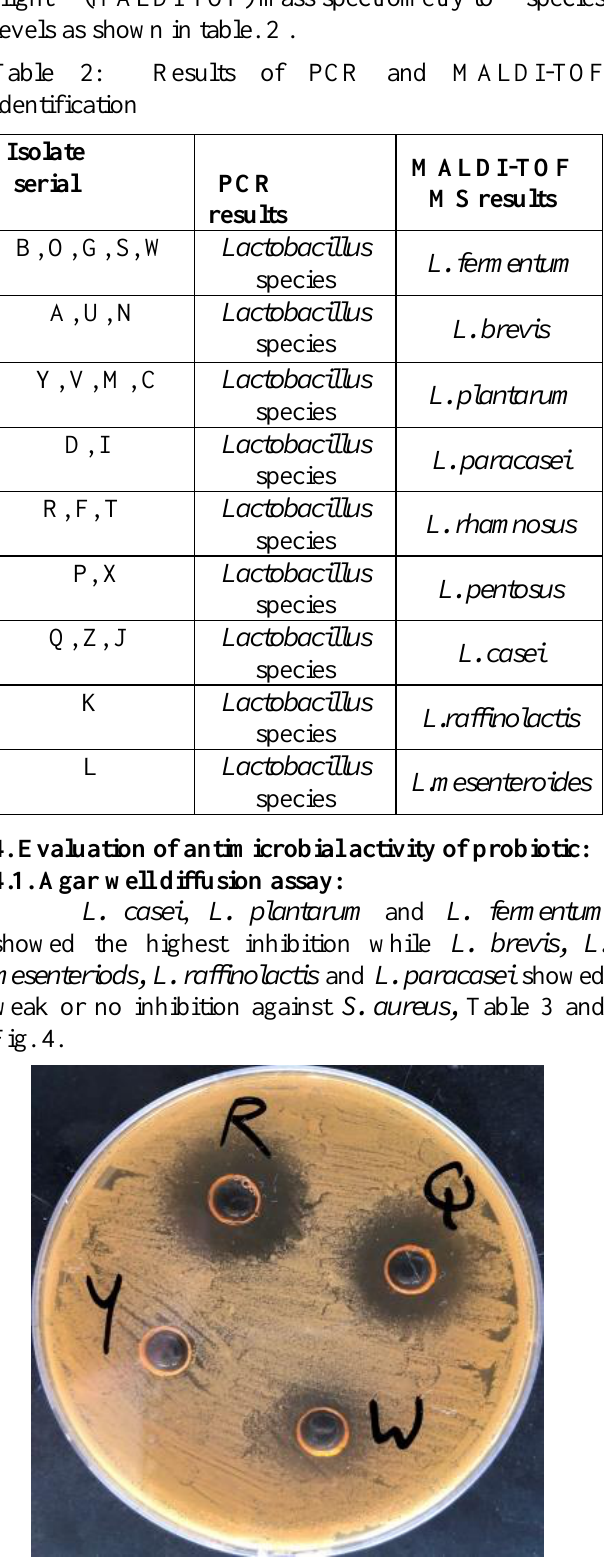
Clear zones around the wells loaded with Lactobacillus cell free supernatant representing the inhibiting activity of lactobacillus against S. aureus. R= L. rhamnosus, Q= L. casei, W= L. fermentum, Y= L.